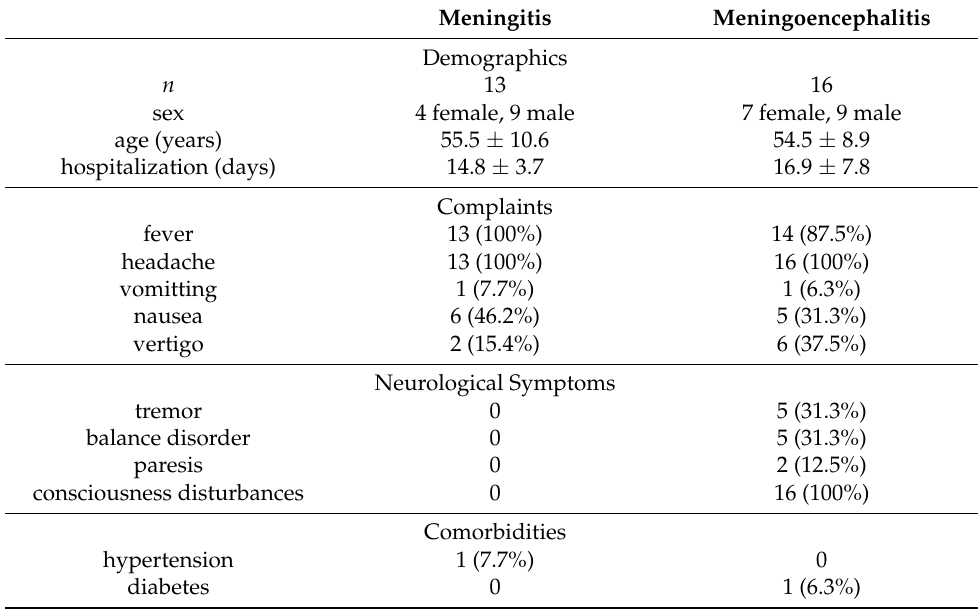
Table 1. Characteristics of TBE patients according to the course of